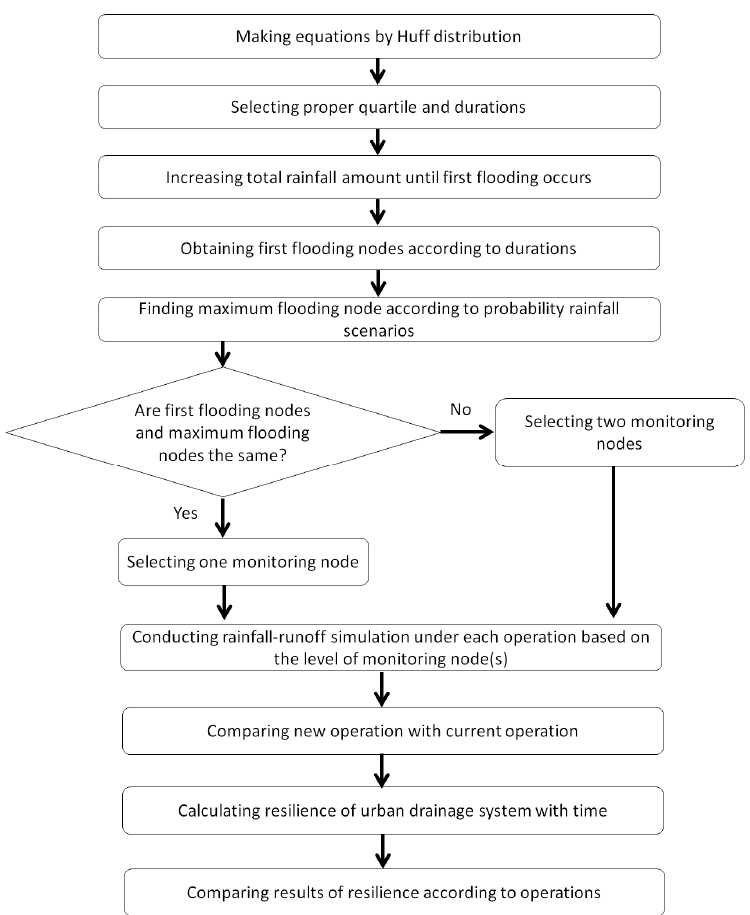
Figure 2. Flowchart for cooperative operation of urban drainage systems.